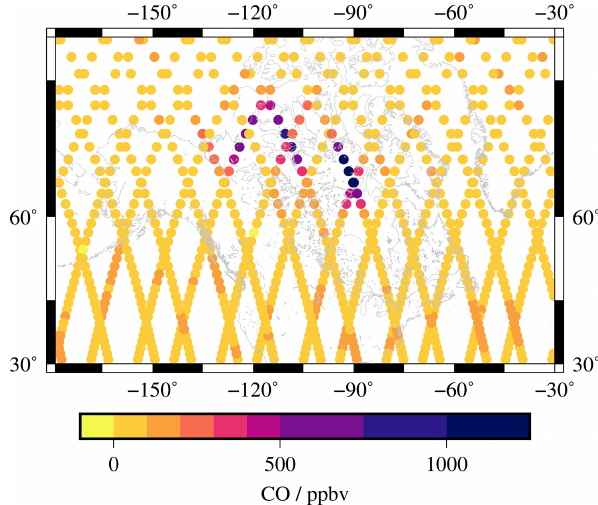
Figure 1. MLS measurements of CO (in parts per billion by vol- ume) at 215hPa ( ≈ 11km altitude) on 14–15 August 2017. These are the first 2d after the PNE on which MLS observed the enhanced CO